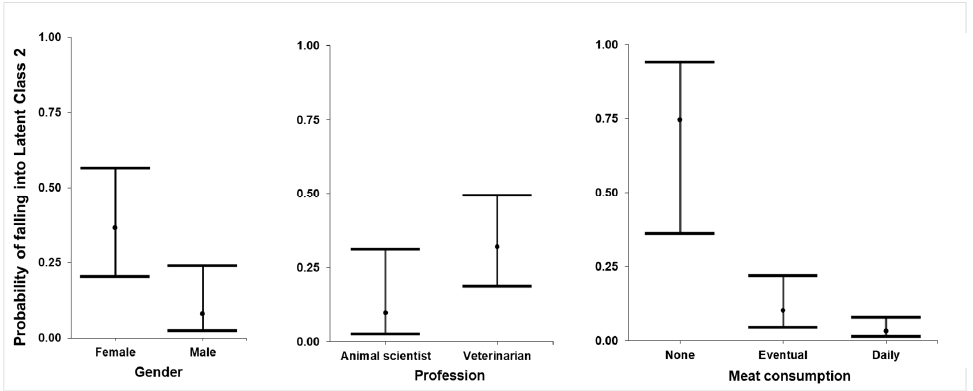
Figure 2. Adjusted respondent probability of falling into Latent Class 2 (pro-cell-based meat, 55